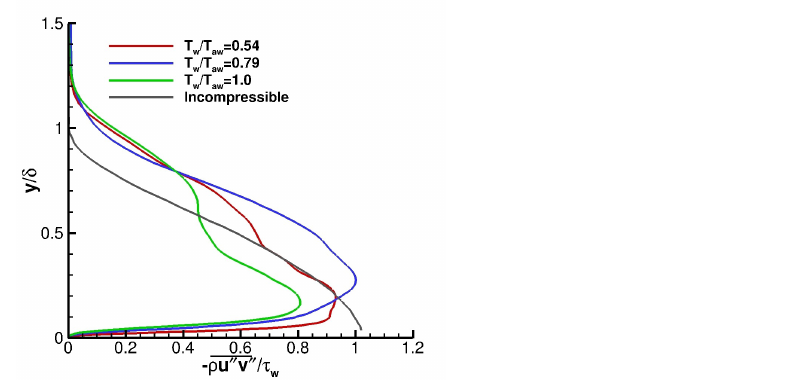
Figure 14. Morkovin scaled dimensionless turbulent shear stress at x / δ = 20 for three wall